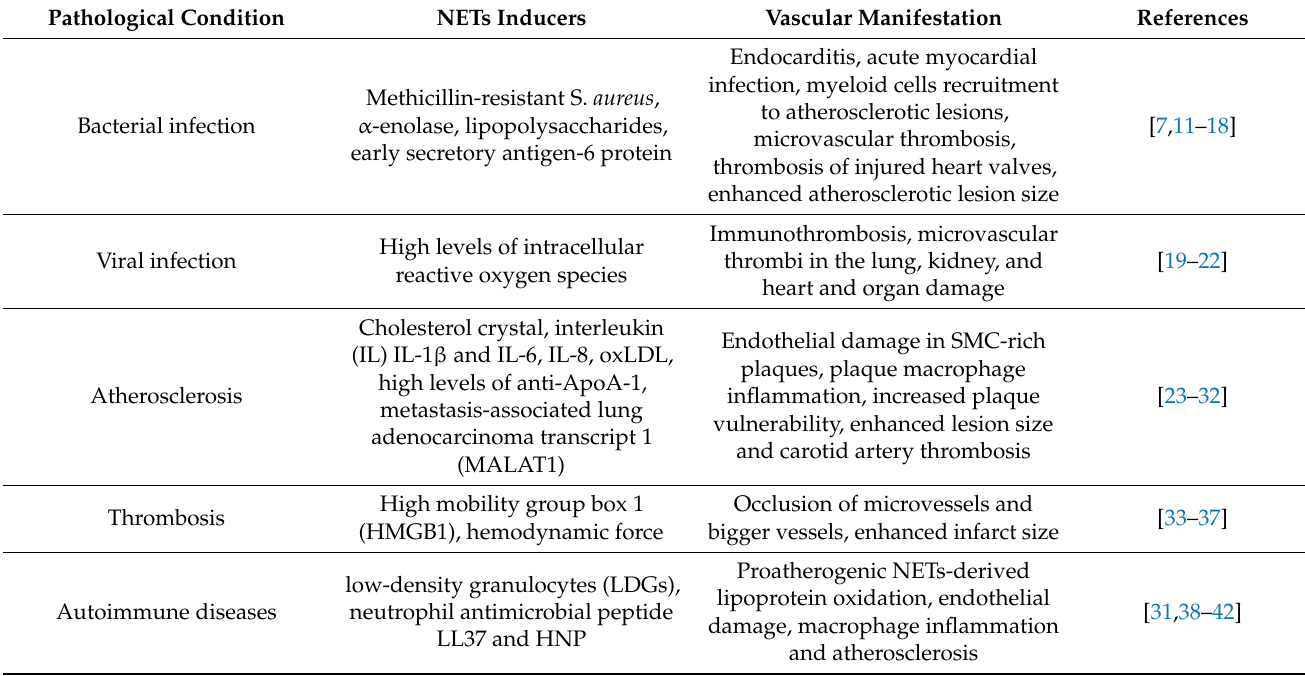
Table 1. List of pathologies involved in the manifestation of NETs-induced vascular diseases. Pathological Condition NETs